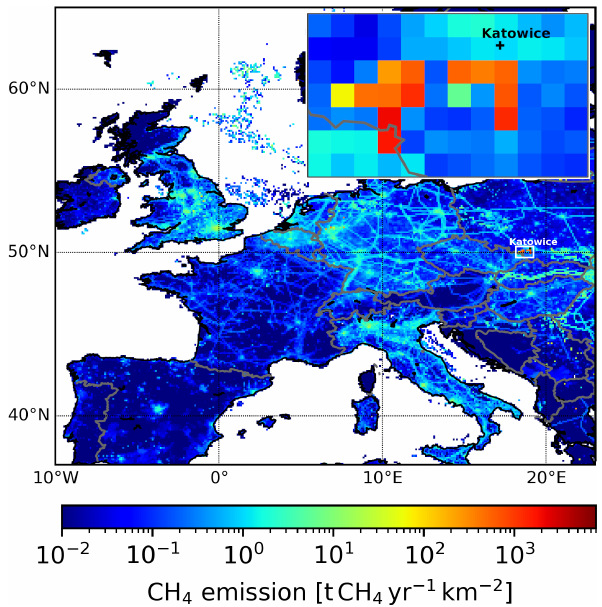
Figure 1. European CH 4 emissions from fossil fuels in 2016. The Upper Silesian Coal Basin (USCB) is located around 50 ◦ N, 19 ◦ E and framed by the white rectangle. A magnification is shown in the inset. Emission map is based on data from Scarpelli et al.